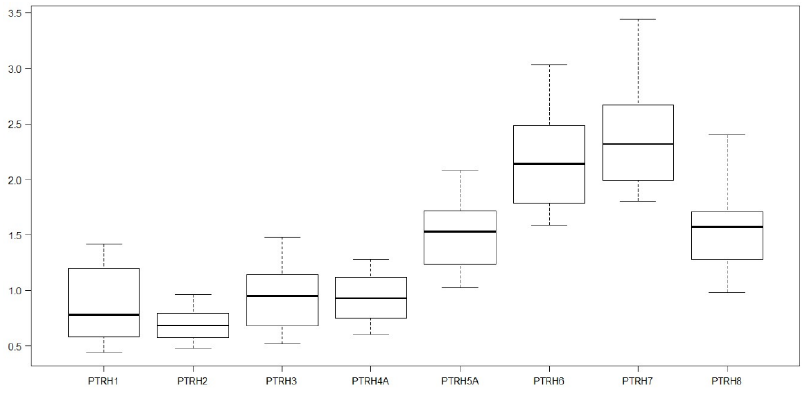
Figure 6. Boxplots: Dryness indexes by RBD.